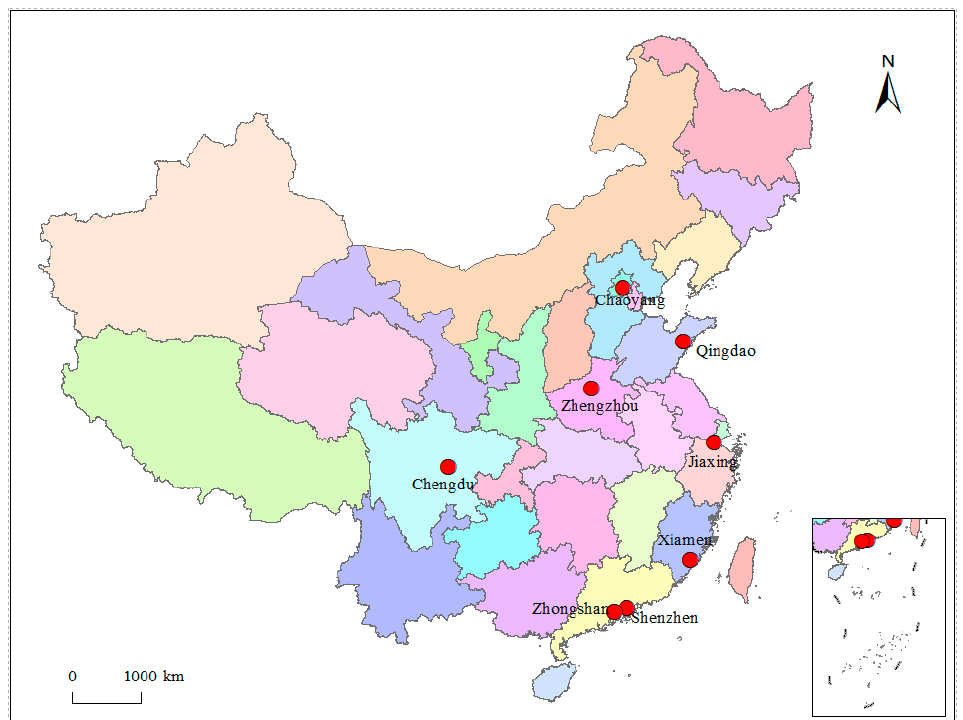
Figure 2. Location map of the sampling cities.